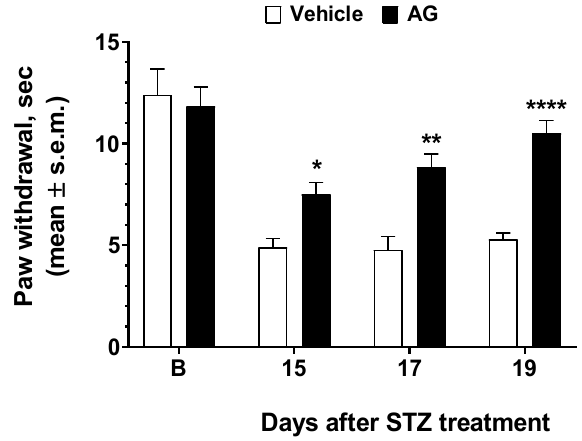
Figure 6. Effects induced by AG in Streptozotocin-induced diabetic mice. Paw withdrawal latency was recorded before STZ treatment (baseline latency, B) and three more times at 15, 17, and 19 thereafter. Vehicle (V, saline 10 mL/kg) and AG (50 mg/kg, 10 mL/kg) were administered three times at day 15, 17, and 19 after STZ injection. * is for p < 0.05, ** is for p < 0.01, and **** is for p < 0.001 vs V. n = 9.